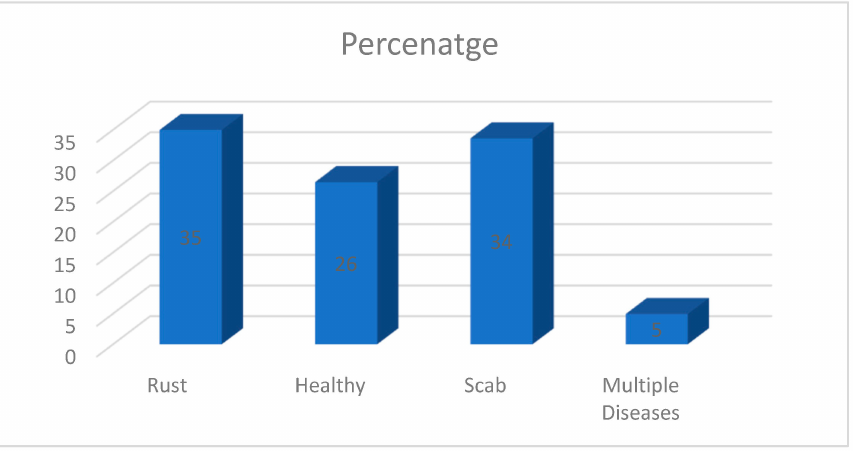
Figure 2. Distribution of classes of Apple leaves disease in Plant Pathology 2020 dataset